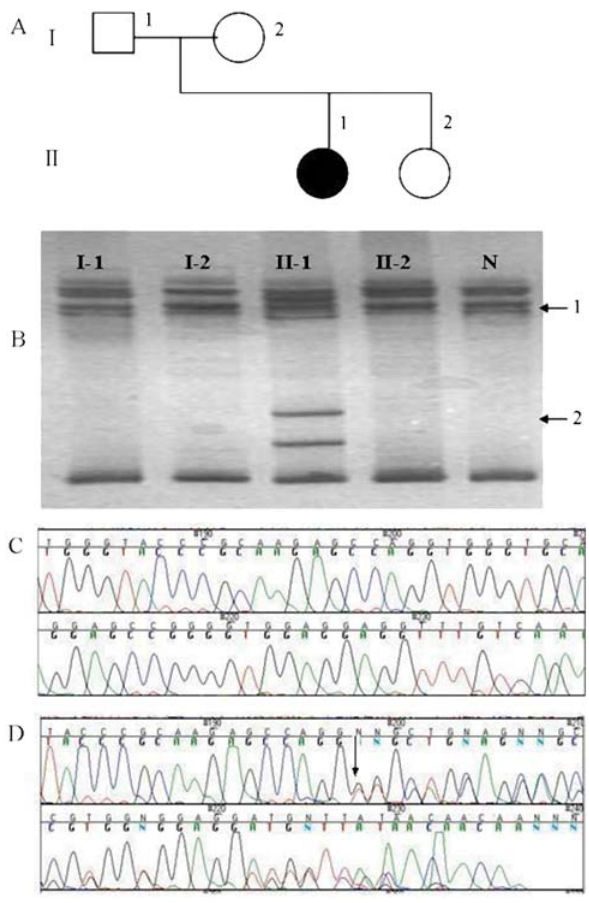
Figure 1 - A , Family pedigree. B , SSCP analysis of the exon 3/intron 3 fragment of the hydroxymethylbilane synthase gene disclosed an abnor- mal banding pattern in the patient (II-2). N, normal control. C , D , Electro- fluorograms showing partial nucleotide sequence of the hydroxymethyl- bilane synthase gene in a normal control (C) and in the patient (D). The TGG deletion in the patient (arrow) disrupts a consensus sequence of the donor-splicing site G/GTGGGTGCA.